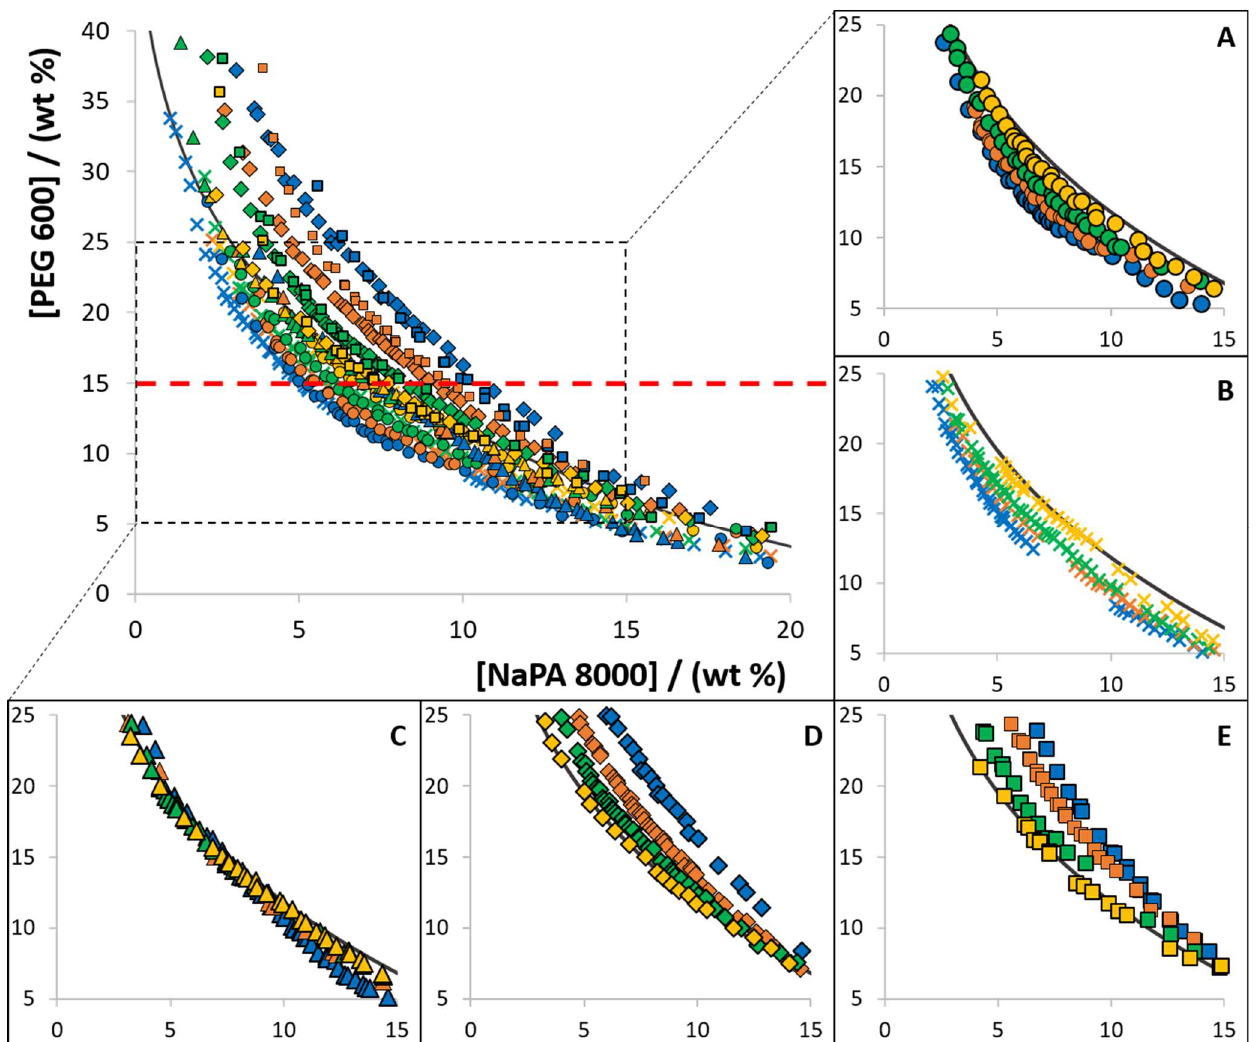
Figure 2. Experimental solubility data, at 300.15 K, for ABS composed of PEG 600, NaPA 8000, and each [Ch]-based IL used as an electrolyte: ( A ) [Ch][Ac] ( • ); ( B ) [Ch]Cl ( × ); ( C ) [Ch][DHP] ( (cid:78) ); ( D ) [Ch][DHcit] ( (cid:7) ); and ( E ) [Ch][Bit] ( (cid:4) ). Distinct colors represent different concentrations, namely 10 wt% ( blue ), 5 wt% ( orange ), 2.5 wt% ( green ), 1 wt% ( yellow ). The ABS formed by PEG 600 and NaPA 8000 without electrolyte is represented by the black line ( ― ).